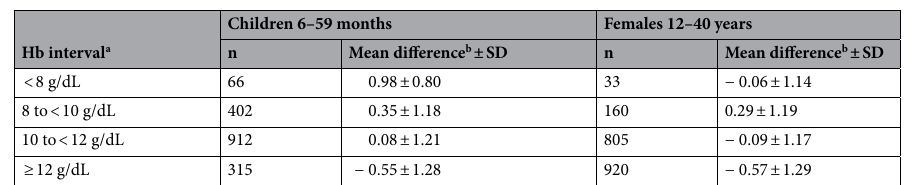
Table 4. Mean differences by Hb concentration interval, children 6–59 months and females 12–40 years. a Average of DBS and HemoCue measures. b